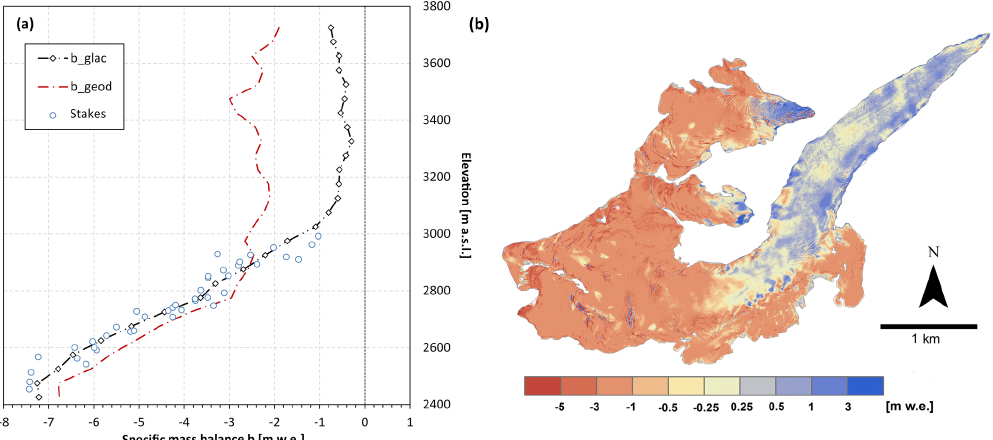
Figure 5. The extraordinary mass balance year 2002/03. (a) Comparison of vertical mass balance profiles (B glac ; B geod ) including the distribution of direct measurement points over the elevation span of the glacier. (b) Spatially distributed difference of the methodical results with main deviations between the methods at elevations higher than 3000ma.s.l. where in situ observations are missing. Note that vertical profiles of the two methods cannot be directly compared due to the effect of glacier dynamics, which leads to more negative geodetic results (than the glaciological ones) in the higher-elevation areas and vice versa in the lower glacier regions.